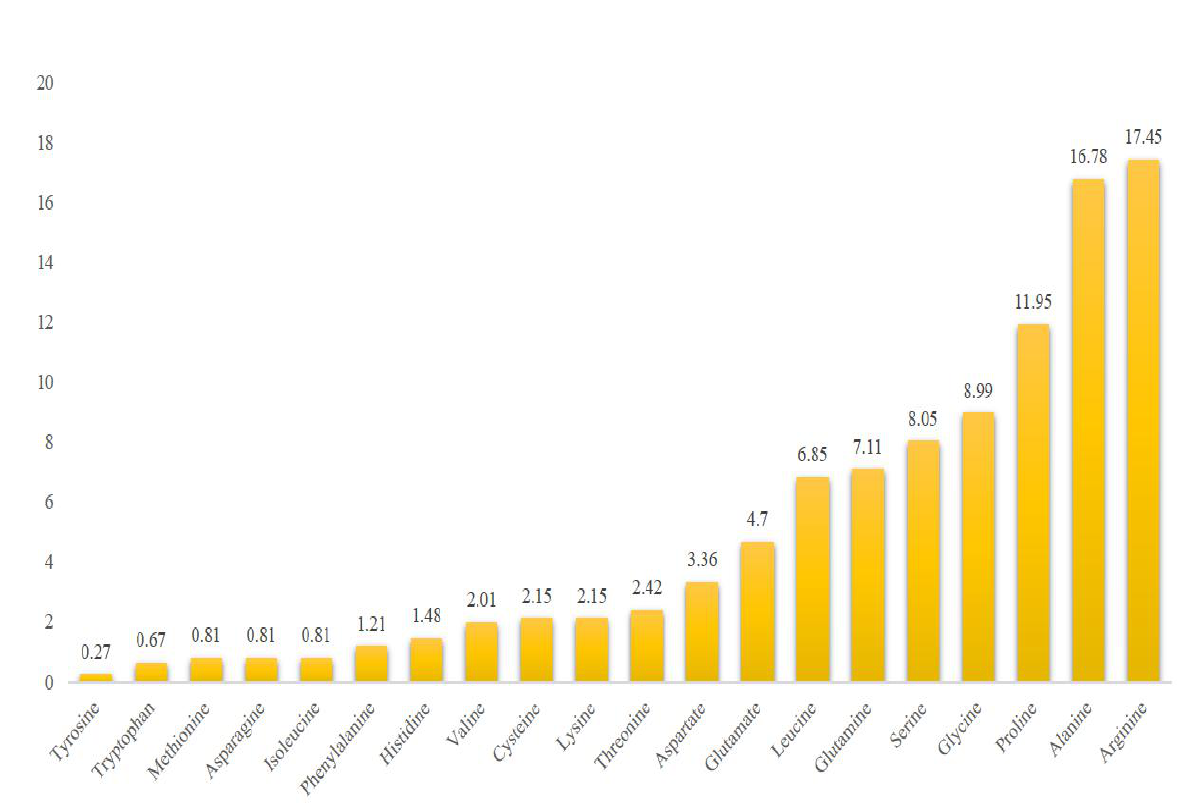
Figure 3. Distribution of amino acids in tri- and hexanucleotide